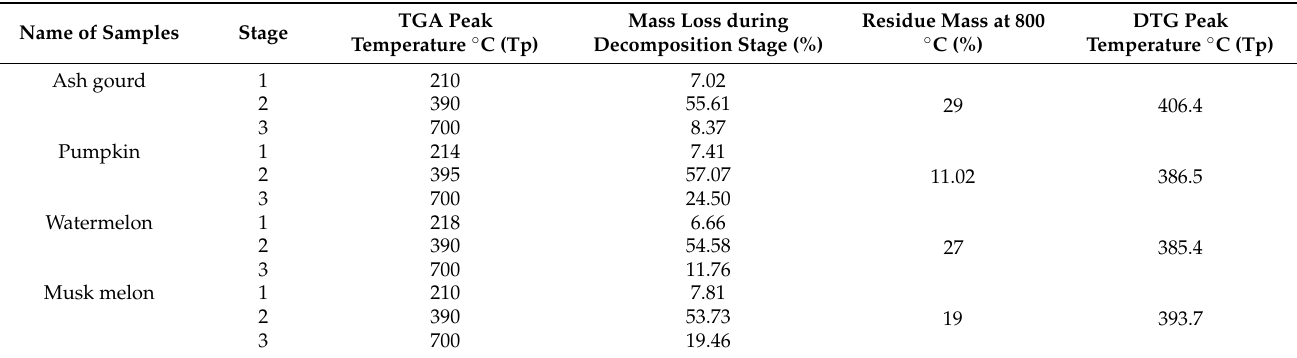
Table 7. Thermal degradation profile by thermogravimetric and derivative thermogravimetric analysis (TGA and